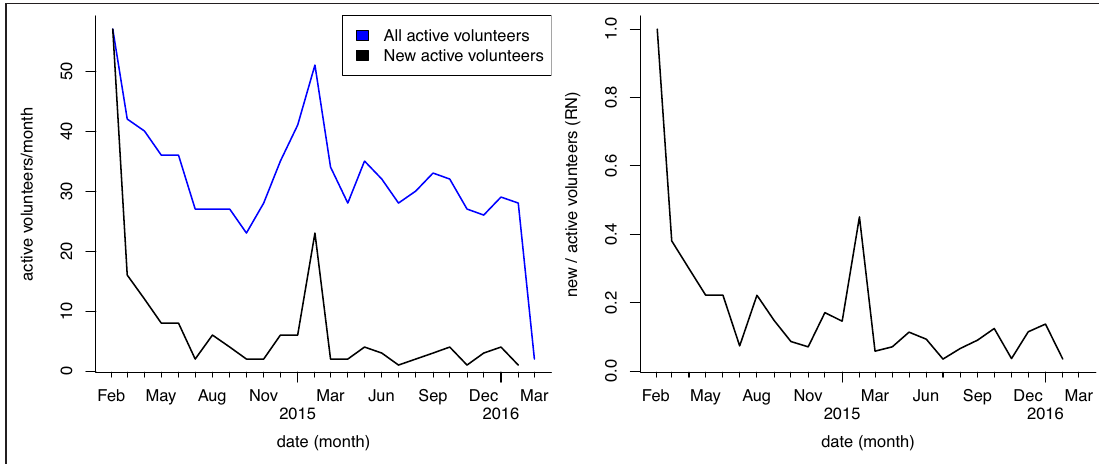
Figure 2: Number of active citizen participants and new active citizen participants per month (entering at least one scan in that month; left panel) and ratio of new volunteers to total volunteers per month (RN, right panel).